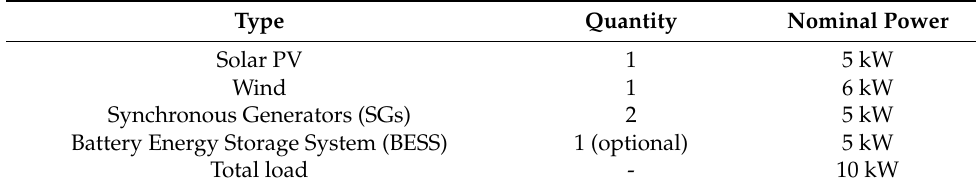
Figure 2. Simulink model of the hybrid power plant. Table 1. Sources and loads of the considered hybrid power